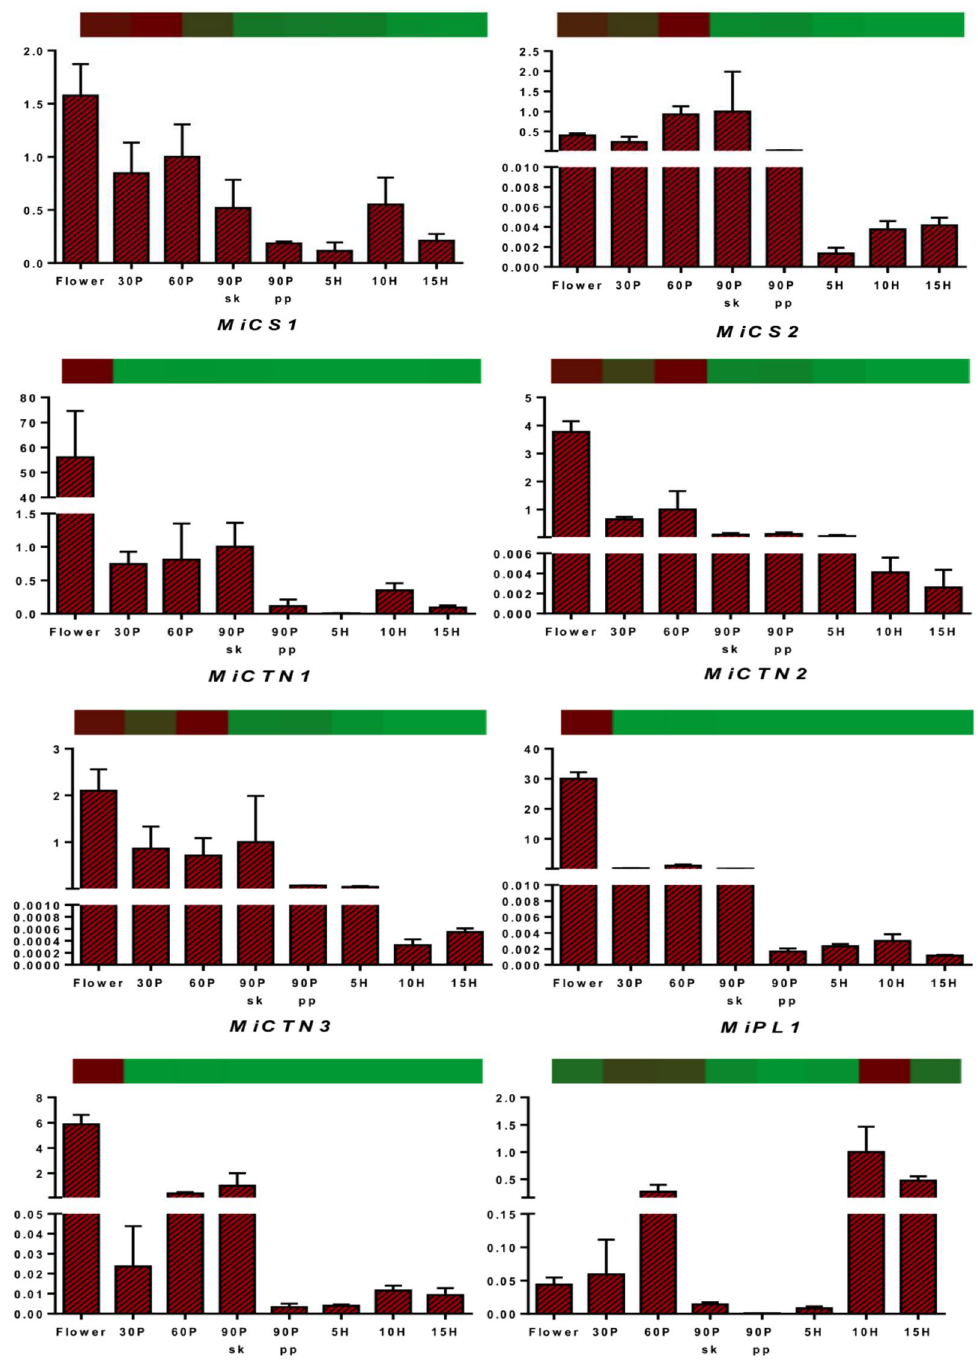
Figure 5. Quantitative reverse-transcriptase PCR validation of various transcripts obtained through RNAseq from carbohydrate metabolism through various tissues (flower and fruit developing and ripening stages). Vertical bars at each data point represent standard error in the relative quantification among the three biological replicates. X-axis represents fruit development and ripening stages and Y-axis represents relative transcript abundance. The horizontal bar above each histogram represents the expression level of the same transcript as obtained through RNAseq analysis, wherein dark-red color indicates higher expression and light-green color indicates lower expression. Gene names are as referred in result section “Transcriptome validation through qRT